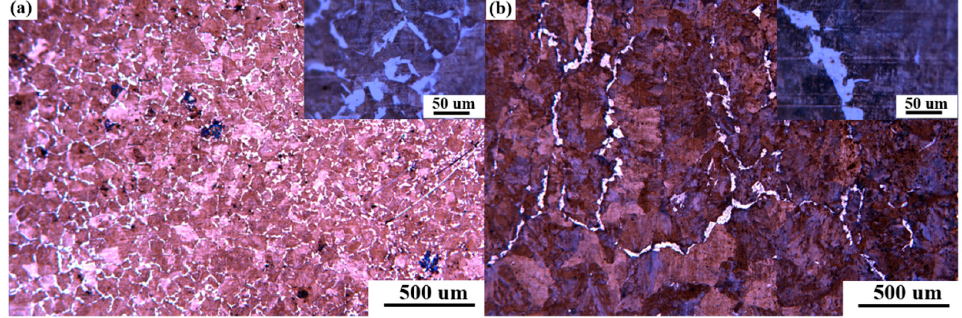
Figure 7. Microstructure of the corner of the continuous casting slab. ( a ) Microstructure of the corner of the ‘oscillation mark’ area; ( b ) microstructure of the corner of the ‘non-oscillation mark’ area.